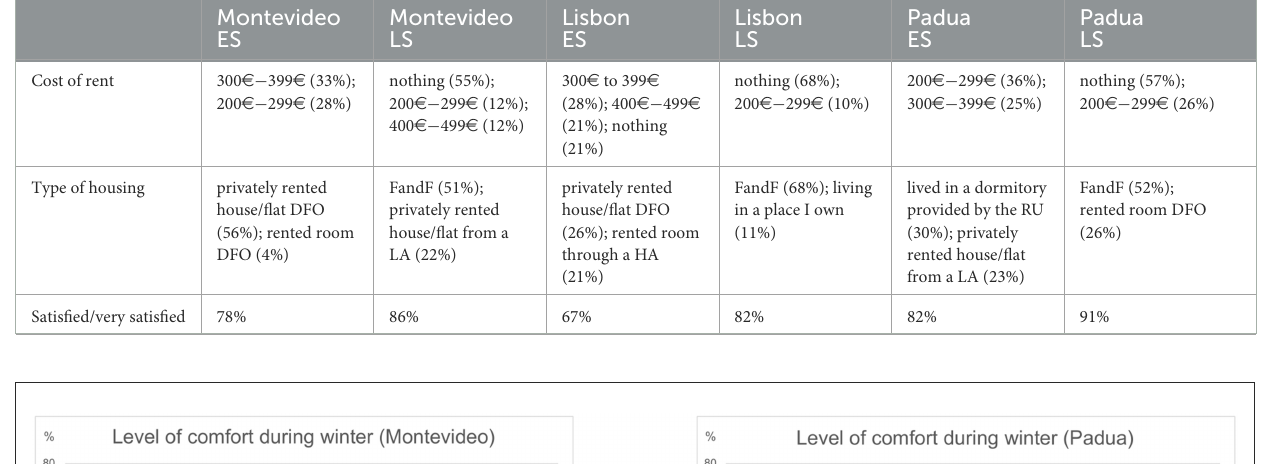
TABLE 4 General description of accommodation (2 most common costs and types of housing) and satisfaction with accommodation for each population (DFO, directly from the owner; FandF, living in a place that belongs to my family or friends; LA, letting agent; HA, housing agency; RU, receiving University).